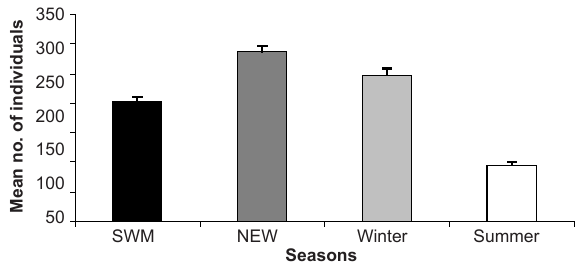
Figure 2. Seasonal abundance patterns of butterfly communities in Kalpakkam